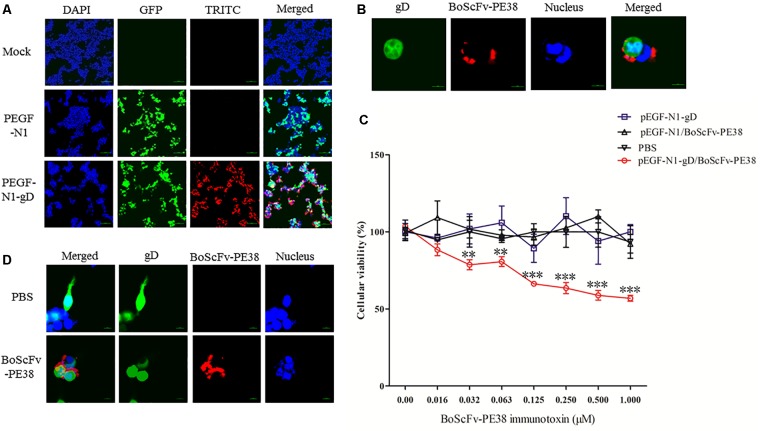
Binding specificity and cytotoxicity of BoScFv-PE38 in gD-expressing 293T cells. (A) Binding specificity of BoScFv-PE38 in gD-expressing 293T cells determined via IFA. 293T cells were seeded on cover slips in six-well plates and cultured to 70% confluency at 37°C over 18–24 h. Then, the PEGF-N1 and PEGF-N1-gD plasmids were transfected into the cells. After 6 h, BoScFv-PE38 (1 μM) was added to the culture medium, and the 293T cells were cultured for an additional 24 h. The 293T cells were subsequently fixed with 4% paraformaldehyde, permeabilized with 0.1% Triton X-100 for 1 h, blocked with 3% BSA, and incubated with the Alexa Fluor 555-anti-His antibody at 37°C for 1 h. Finally, the nuclei were counterstained with DAPI (blue), and the cell samples were examined with a fluorescence microscope (Leica EL 6000). (B) Localization of BoScFv-PE38 in gD-expressing 293T cells determined via CLSM. The 293T cells were treated as described above. Then, 293T cell samples were examined with a confocal laser-scanning microscope (Leica). (C) Cytotoxicity of BoScFv-PE38 in gD-expressing 293T cells. 293T cells were seeded on cover slips in 96-well plates and cultured to 70% confluency at 37°C over 18–24 h. Then, the PEGF-N1 and PEGF-N1-gD plasmids were transfected with Lipofectamine 3000 (Life Technology, United States) according to the manufacturer’s instructions. After 6 h, BoScFv-PE38 (0–1.0 μM) was added to the culture medium, followed by cultivation at 37°C for 24 h. Then, cell proliferation activity was measured with the CellTiter 96 Aqueous One Solution Cell Proliferation Assay (MTS) Kit (Promega) according to the manufacturer’s instructions, and the OD490 values of the test wells were read with a microplate reader for calculation of the cellular viability. All the statistics were analyzed through analysis of variance (ANOVA) using SPSS software, version 18.0, and the fitting curves of various concentrations of BoScFv-PE38 were drawn with GraphPad Prism 5.0, respectively. “∗∗” represents statistically significant differences (P < 0.01). “∗∗∗” represents statistically very significant differences (P < 0. 001). (D) Karyomorphism of gD-expressing 293T cells after treatment with BoScFv-PE38. 293T cells were seeded on cover slips in six-well plates and cultured to 70% confluency at 37°C over 18–24 h. Then, the PEGF-N1-gD plasmid was transfected into the cells. After 6 h, BoScFv-PE38 (1 μM) was added to the culture medium (PBS treated, as the negative control), and the 293T cells were cultured for 24 h. The 293T cells were then fixed with 4% paraformaldehyde, permeabilized with 0.1% Triton X-100 for 1 h, blocked with 3% BSA, and incubated with the Alexa Fluor 555-anti-His antibody at 37°C for 1 h. The nuclei were counterstained with DAPI (blue). Then, the karyomorphism of 293T cell samples was examined with a confocal laser-scanning microscope (Leica).